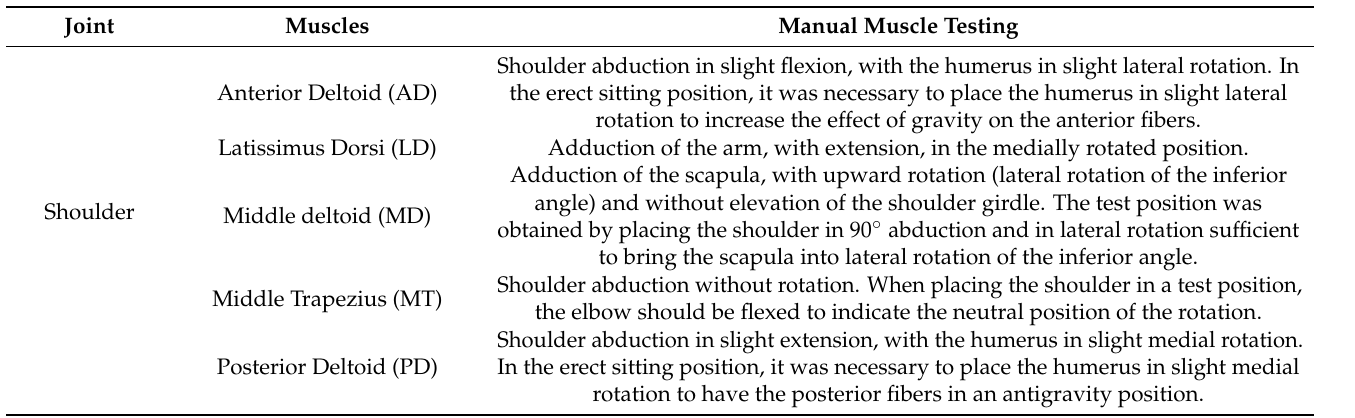
Table 1. Description of MVC